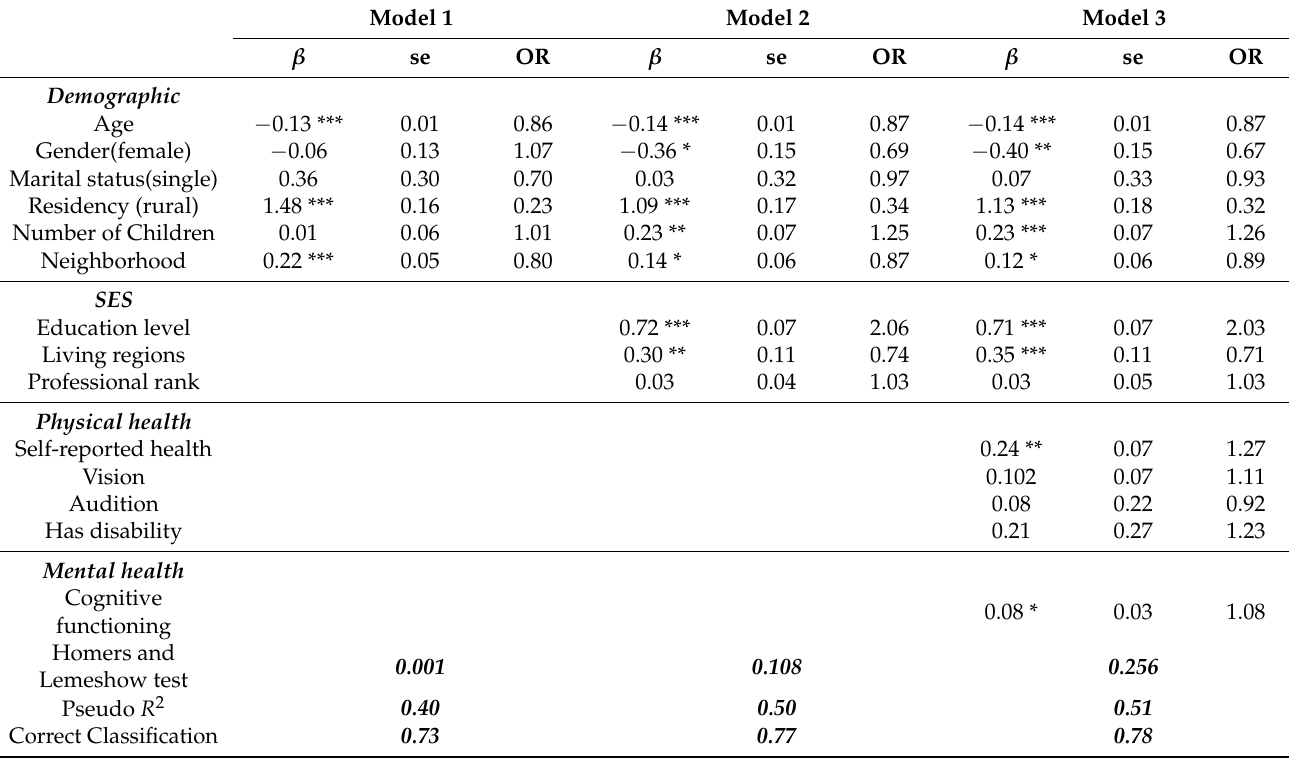
Table 2. Binary logistic regression of social media access among older adults (n = 1399). Model 1 Model 2 Model